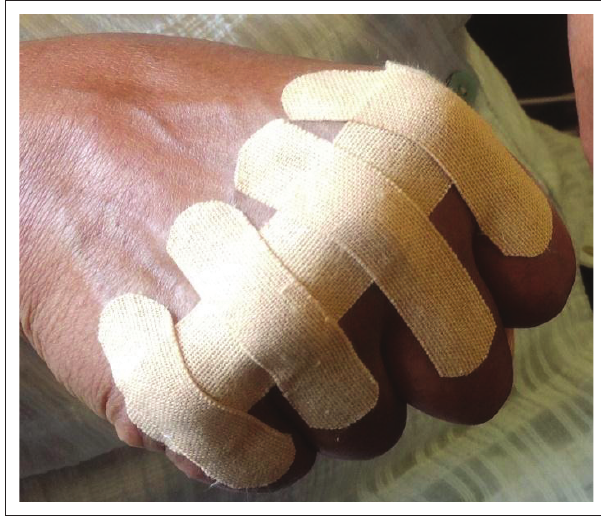
FIGURE 1: Application of Kinesio Taping ®